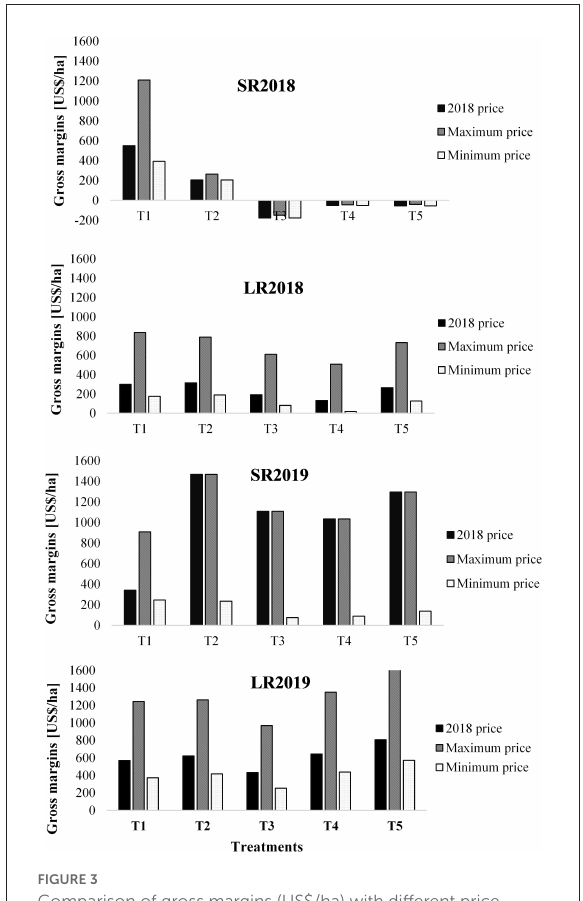
FIGURE3 Comparison of gross margins (US$/ha) with different price scenarios among treatments over 4 crop-growing seasons during 2018 and